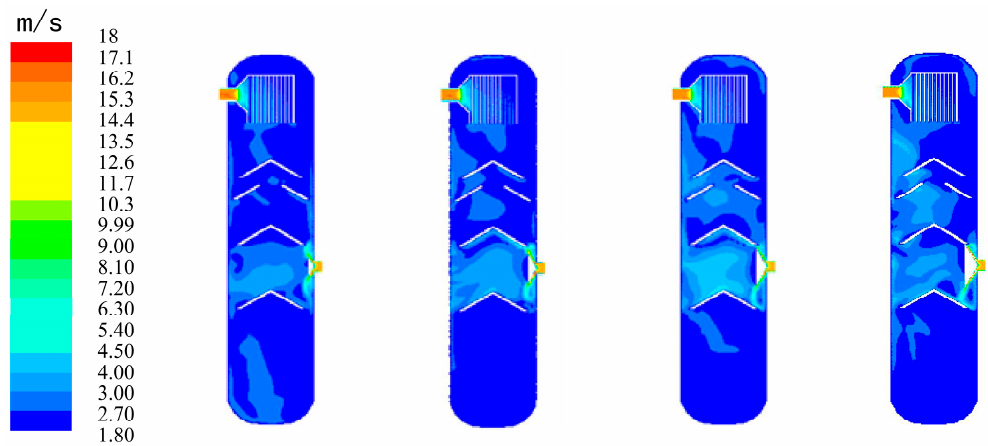
Figure 10. Simulated result of separator’s separation efficiency under different lengths of diversion device.